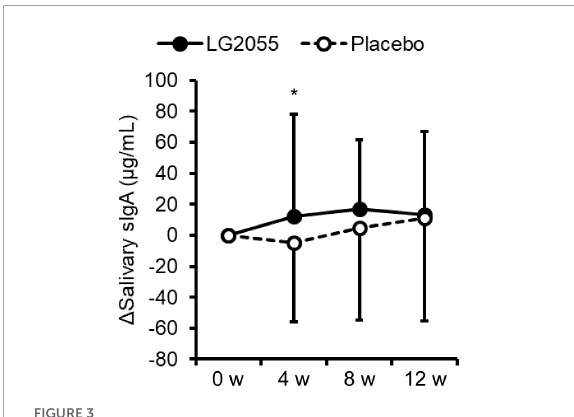
FIGURE3 Comparison of the amount of change from baseline of salivary sIgA concentration ( (cid:49) salivary sIgA). Data are shown